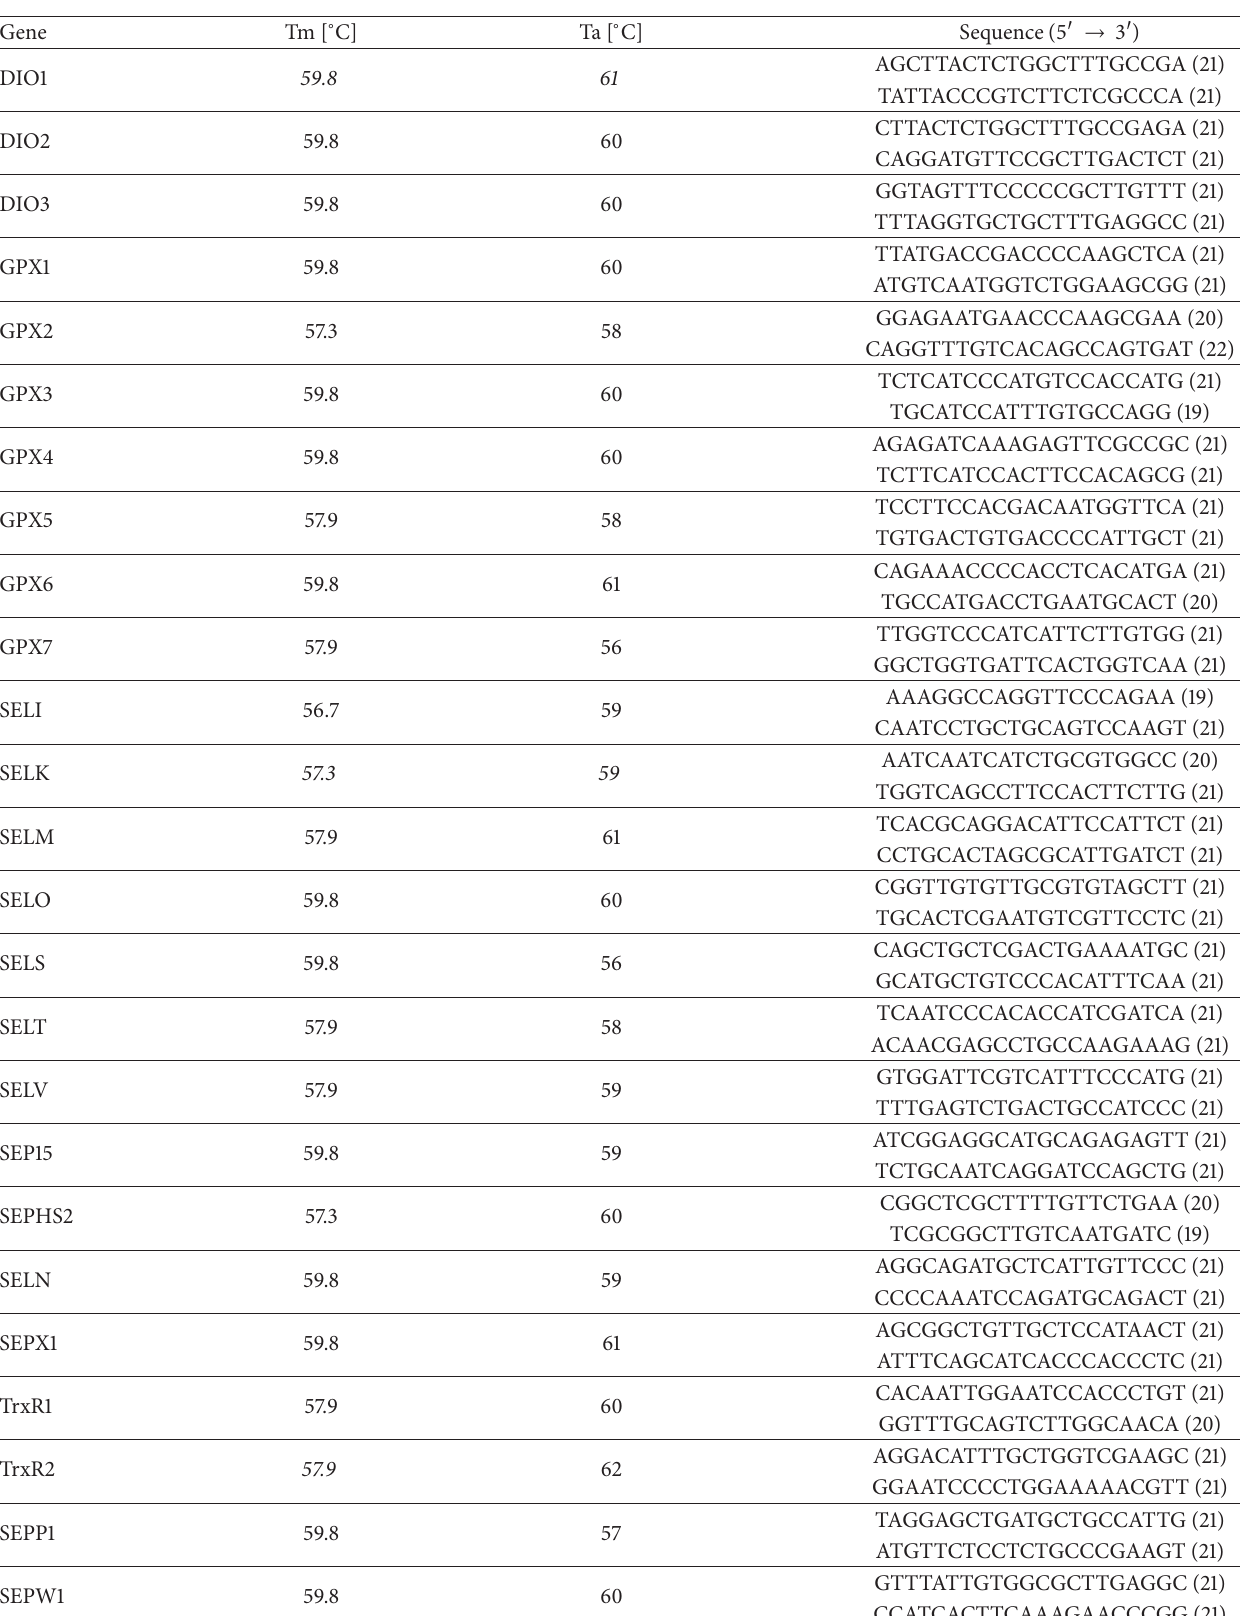
Table 1: Parameters for RT-qPCR